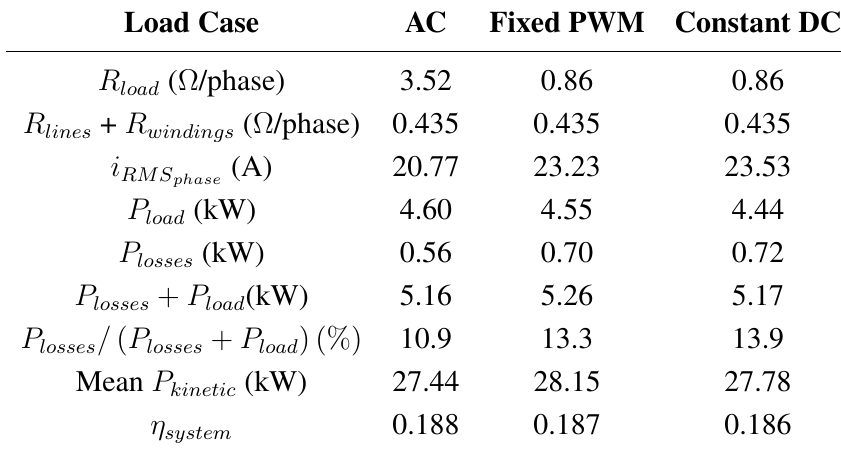
Table 3. Measured resistances, calculated RMS current in each phase, calculated power, P (from Table 1), fraction of losses to P kinetic